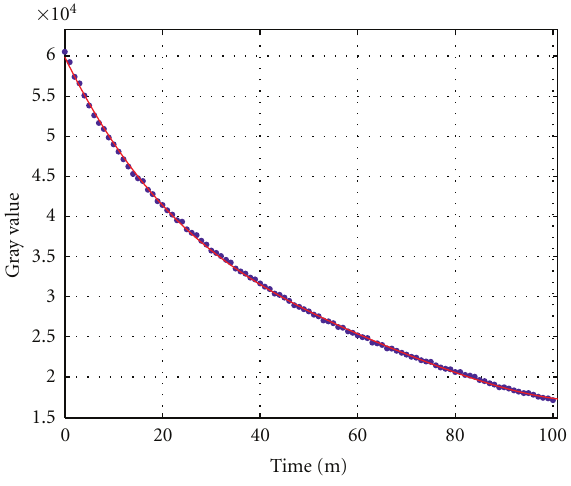
Figure 7: Decay curve of light